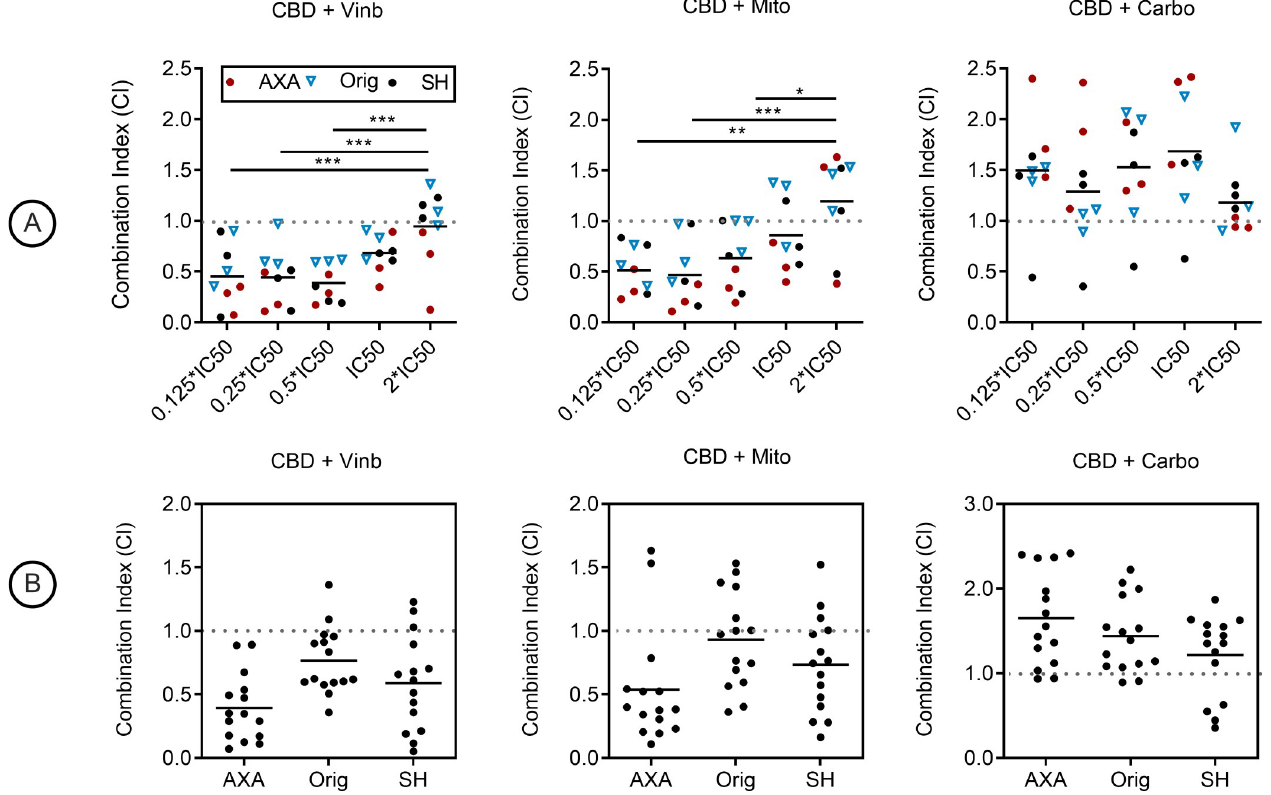
Fig 2. Combination treatment of CBD with mitoxantrone, vinblastine, or carboplatin in canine urothelial carcinoma cell lines. Combination index (CI) calculations in AXA, Orig, SH treated with CBD and vinblastine, CBD and mitoxantrone, or CBD and carboplatin. Dose pairings were chosen from respective IC50 curves. (A) Mean CI values from 3 independent experiments; stratified by dose-pairing. CI < 1 was synergistic, C = 1 was additive, and C > 1 was antagonistic. Significance was recorded at � P < 0.05, �� P < 0.01, ��� P < 0.001. (B) Mean CI values stratified by cell line independent of dose pairings.